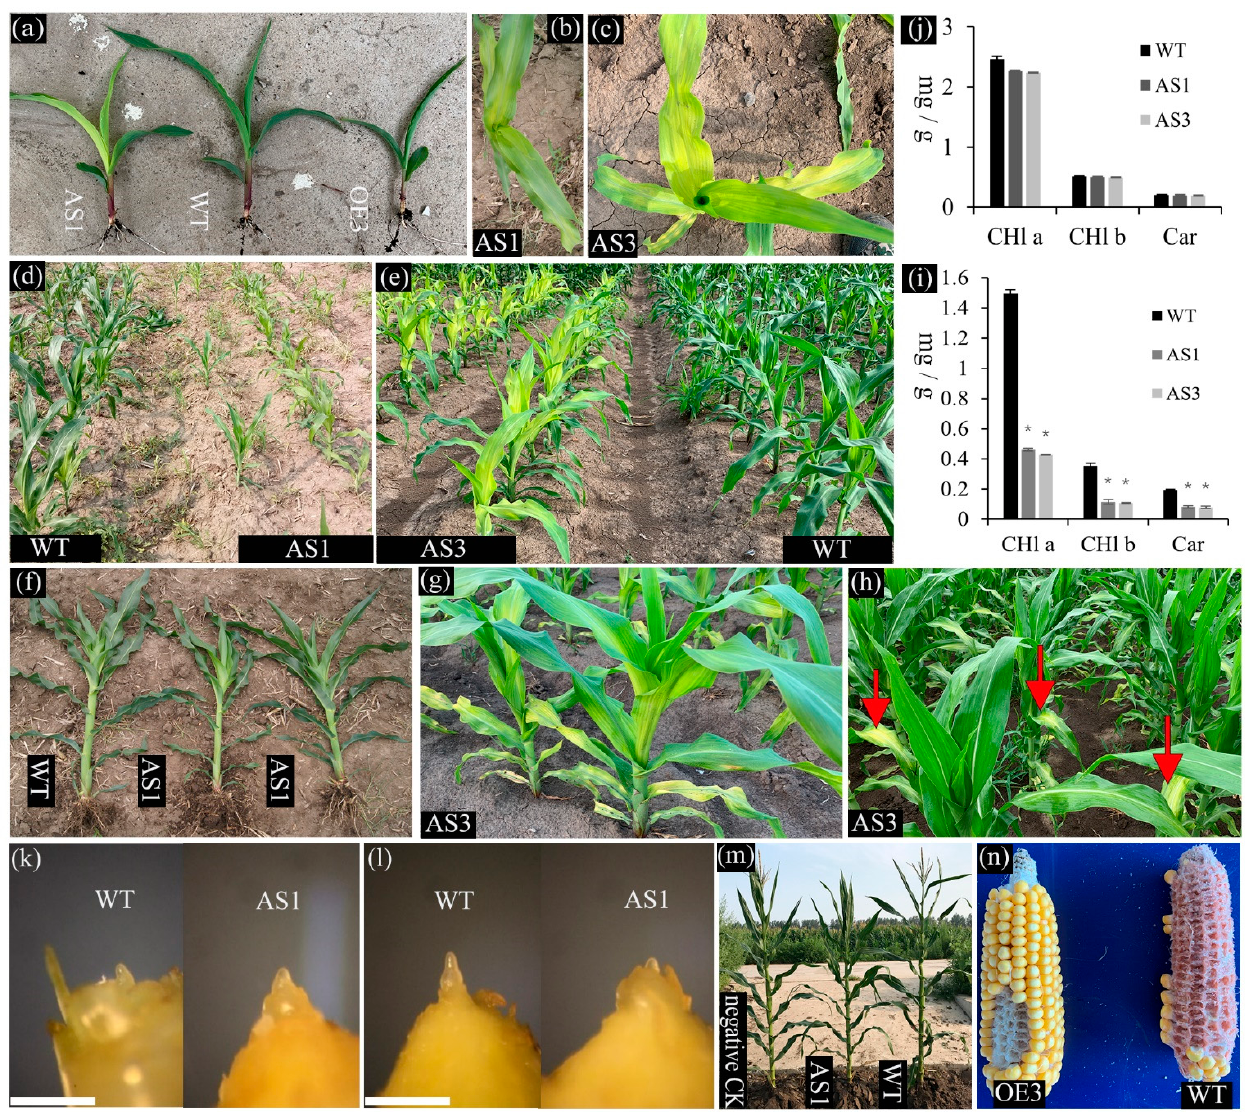
Figure 3. The perturbation of SDG102 expression induces pleiotropic effects on plant development. ( a – h ) Examples of visible phenotypes in the down- (AS1 and AS3) and upregulation (OE3) lines of SDG102 expression compared with the wild-type (WT), including the slow growth rate at seedling stage ( a ), yellow leaves in AS1 ( b , d ) and AS3 ( c , e ) before V8 (the seedlings with eight leaves of fully extended collars). Leaves color of AS1 returned to normal ( f) after V8. But the bottom leaves of AS3 remained yellow after V8 ( g ) and they returned to normal until the V10 stage despite a few yellow spots remaining on the bottom leaves ( h ). ( i , j ) Photosynthetic pigment content in leaves of the WT and SDG102 downregulation expression plants (AS1 and AS3). Chlorophylls (Chl a and Chl b) and carotenoids (Car) were measured in acetone extracts from the second top leaf at V6 ( i ) and R1 (silking stage; ( j )) growth stages. Values based on fresh weight and given as the mean ± standard deviation of three independent determinations. Asterisks (*) indicate statistically significant differences between the indicated genotypes and the WT by the Student’s t-test analysis ( p < 0.01). ( k , l ) Morphological changes of maize shoot apices collected from V4 stage plant ( k ) before and V5 stage ( l ) during the floral transition of the WT and SDG102 downregulation expression plants (AS1). Scale bars ( k , l ) = 1 mm. ( m ) AS1 displayed a late-flowering phenotype. ( n ) Cob color of OE3 changed from red to white. Negative CK = wild type segregants.